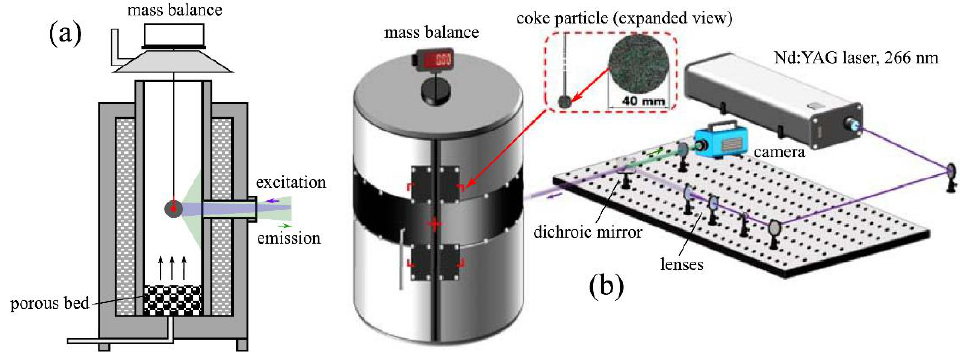
Figure 14. ( a ) The schematic of the furnace and ( b ) setup of phosphor thermometry [126]. Reprinted with permission from [126]. Elsevier, 2021.